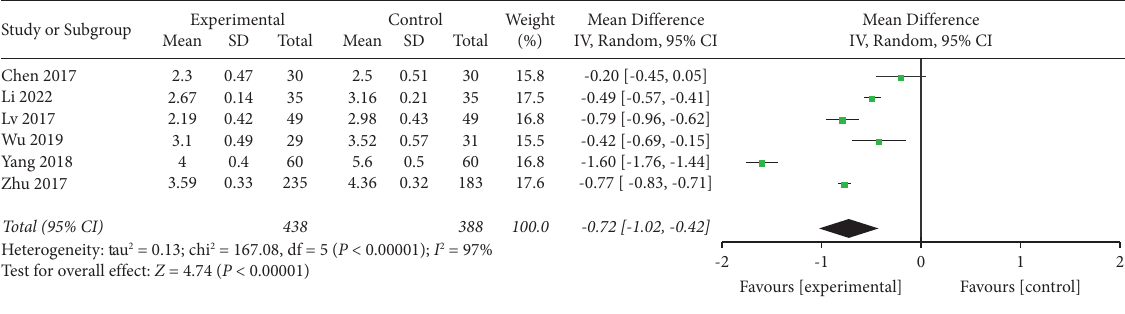
Figure 8: Comparison of the VAS at 72h between the AA group and the control group.